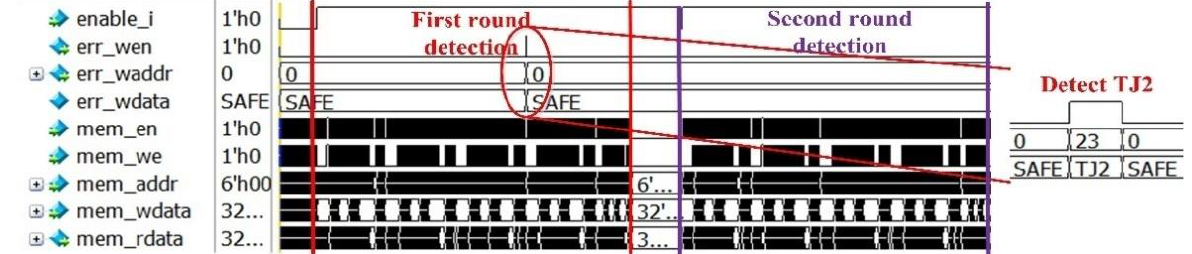
Figure 11. Detection result for HT2.